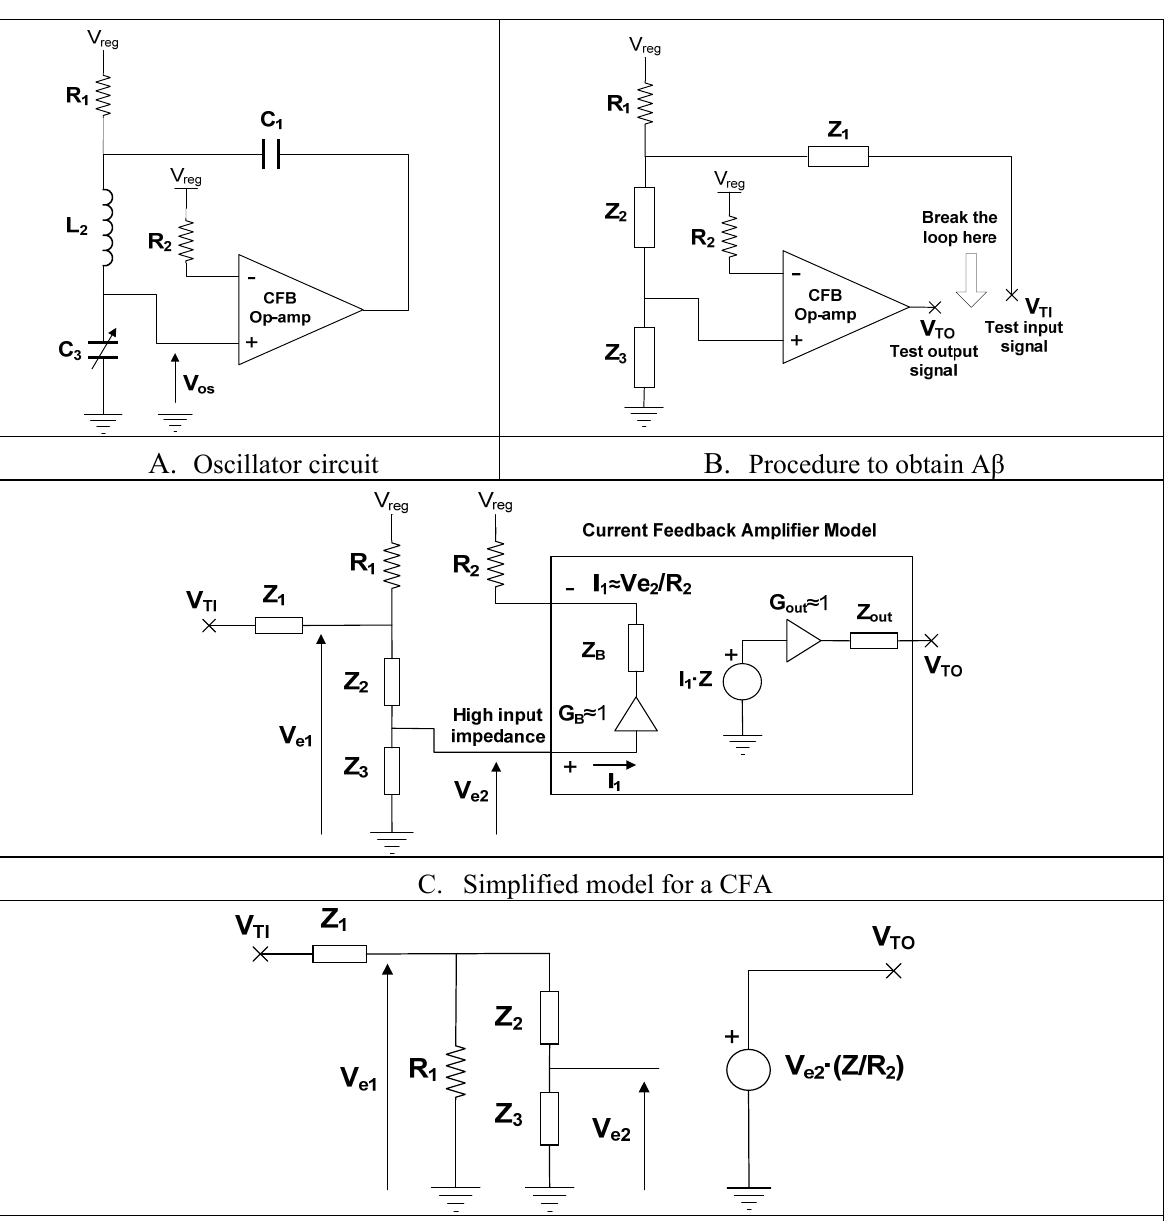
Figure 10. Simplified CFA model to obtain the oscillation